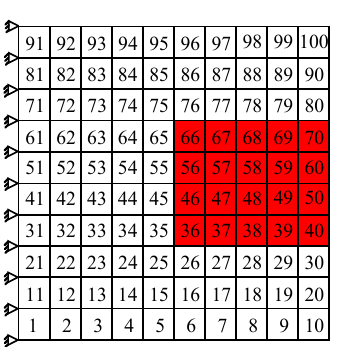
Table 5. Comparison between the damping optimization results for the first order and the results corresponding to the full coating structure.